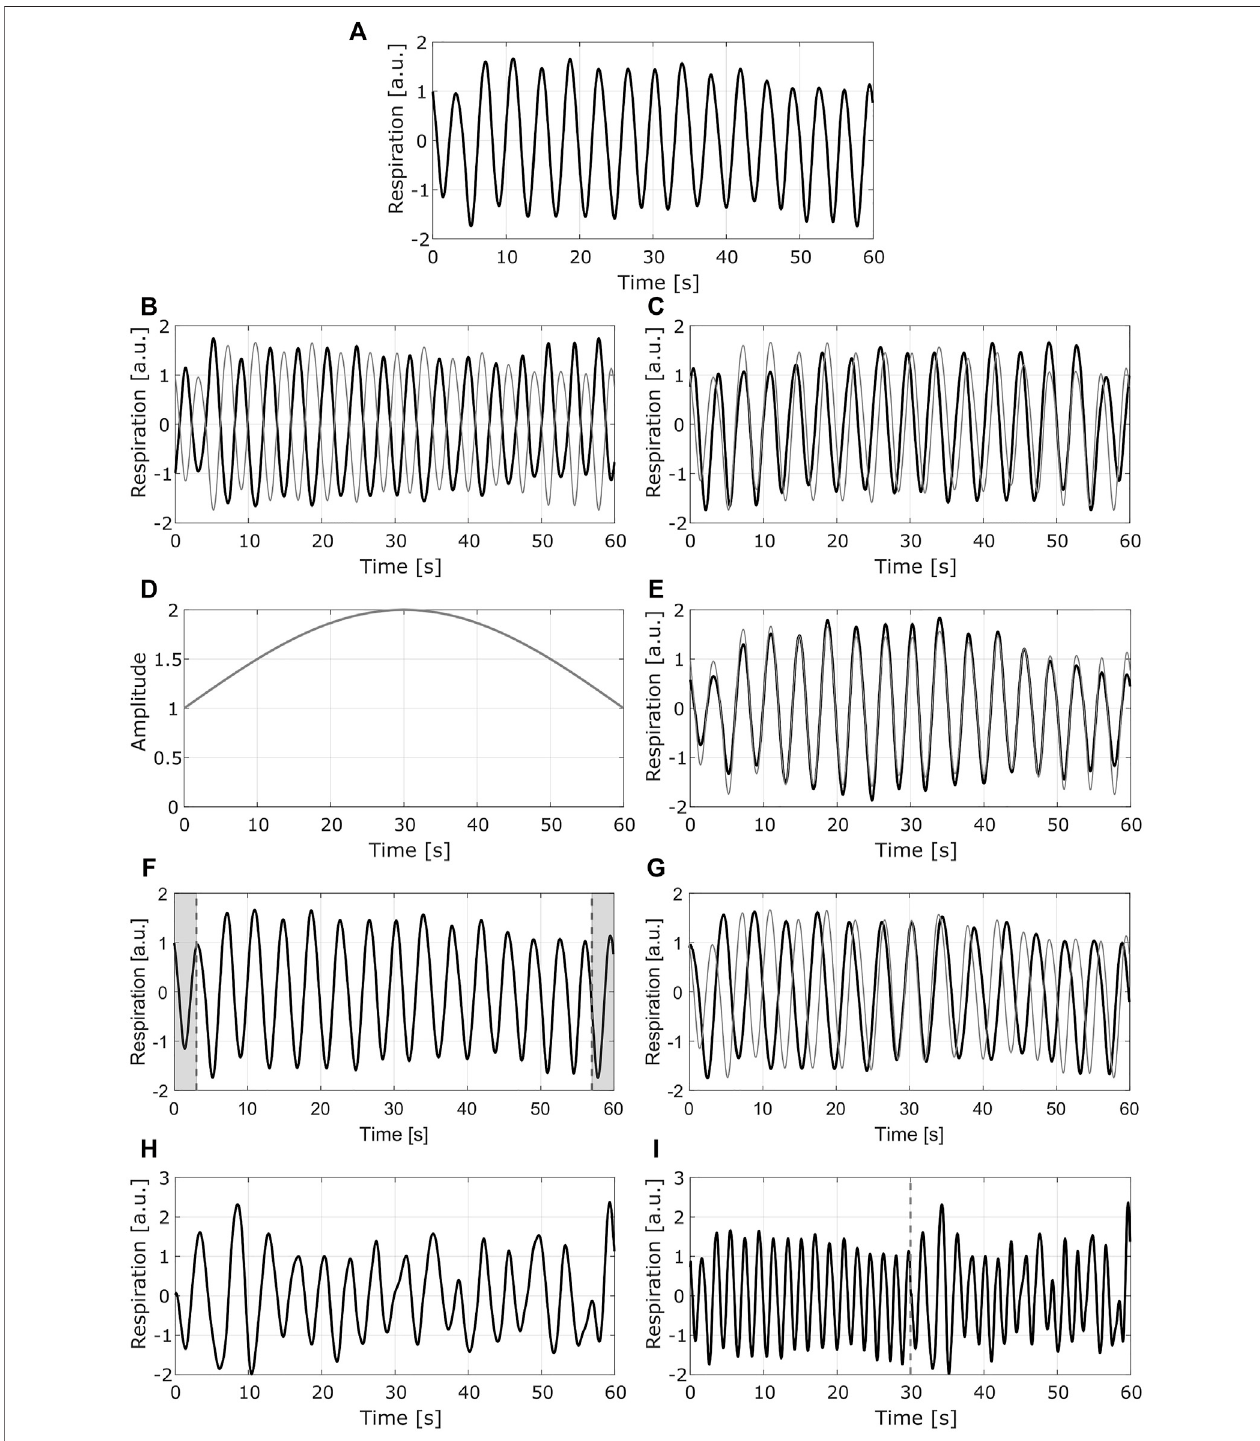
FIGURE 4 | Example of the data augmentation methods. Each row presents one method (A) Original signal (B) Mirrored signal with respect to y axis (C) mirrored signal with respect to x axis. (D) Modulating signal used for the second method (E) normalized modulated signal ( F) Resulting segment after removing the 10% of the points(shadedareasateachendofthesignal) (G) resampledsignalwithslowerbreathingrate (H) Secondoriginalsignaltobeconcatenatedtothe fi rstone (I) resampled signalwithfasterbreathingrate.In (B)(C)(E) and (G) ,thegraylineshowstheoriginalsignal.In (I) thedashed graylinecorrespondstothepointinwhichthesignals are concatenated; the left side corresponds to the signal in (A) , the right side to the signal in (H) (a.u.) stands for arbitrary units.